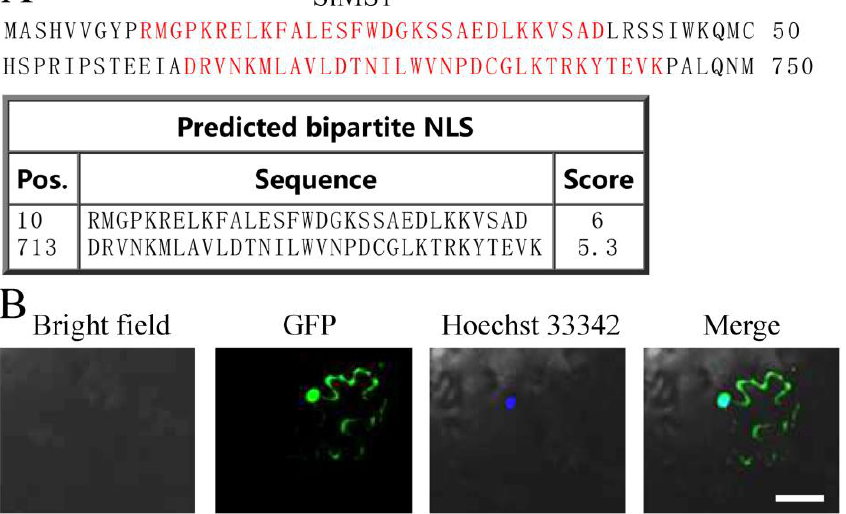
Figure 2. Nuclear localization signal prediction and subcellular localization of SlMS1 in tobacco cells. ( A ) Nuclear localization signal of SlMS1 was predicted on https://nls-mapper.iab.keio.ac.jp/cgi-bin/ NLS_Mapper_form.cgi, accessed on 12 August 2022, and the red letters stand for potential nuclear localization signal. ( B ) Confocal image of tobacco leaf cells expressing SlMS1 -GFP. Scale bar: 50 µ